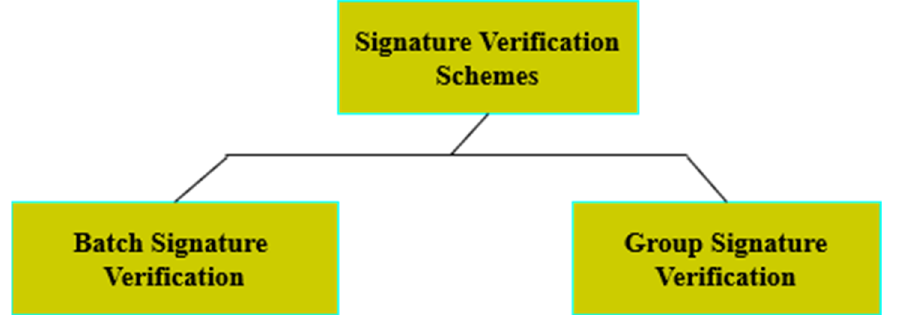
Figure 5. Classification based on signature verification